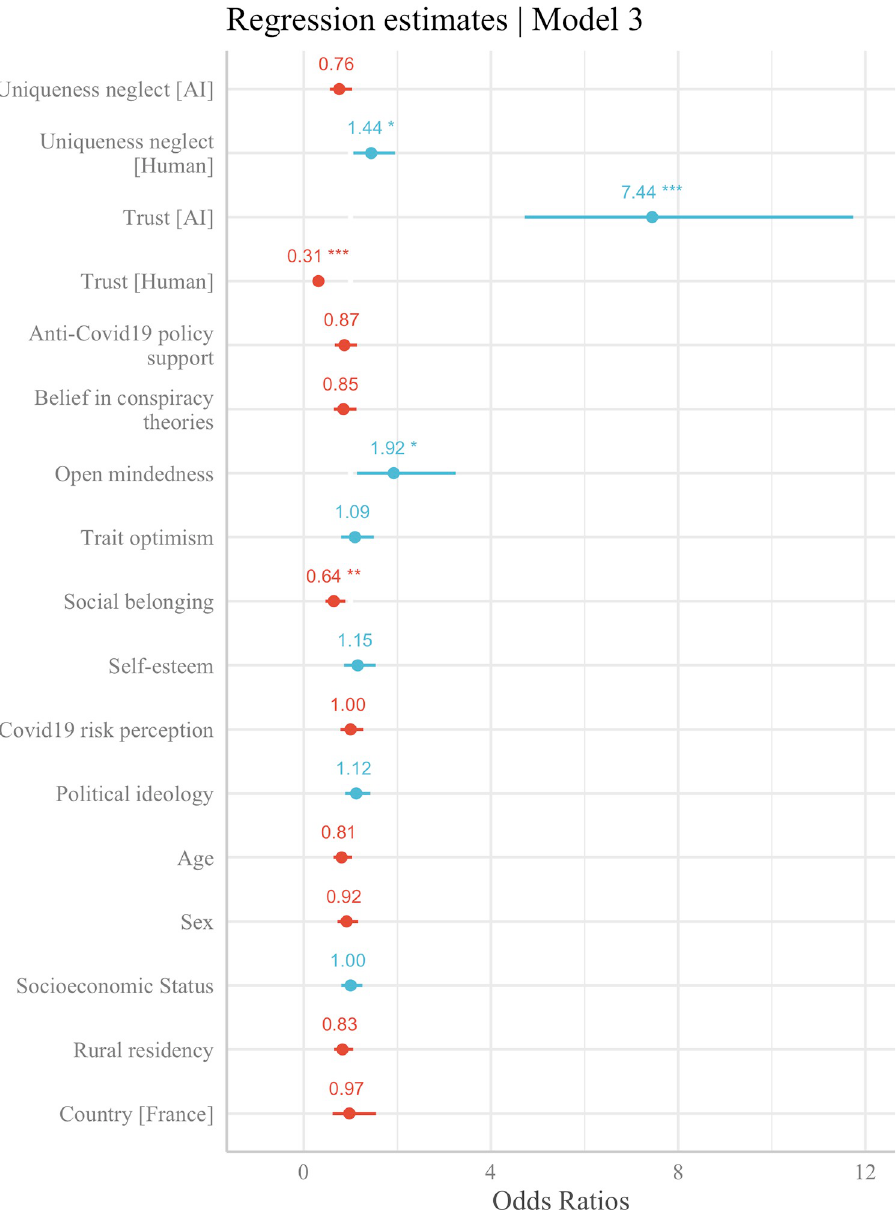
Fig 1. Odds ratios shown for predictors of medical AI adoption in Model 3. Note : Dots indicate odds ratios and lines indicate 95% confidence intervals, red (blue) indicates negative (positive) coefficients, � p < .05, �� p < .01, ��� p <